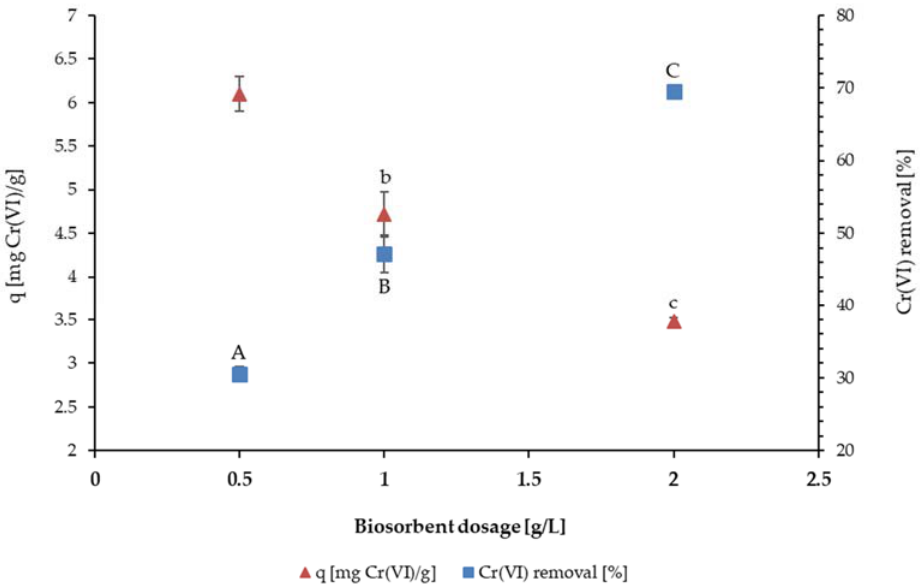
Figure 3. Effect of Pseudopediastrum boryanum var. longicorne concentration on chromium(VI) biosorption. Process conditions: initial metal concentration 10 mg/L; pH 2.0; temperature 22.0 ± 1.0 °C. Difference in letter index indicates a statistically significant difference ( p < 0.05).